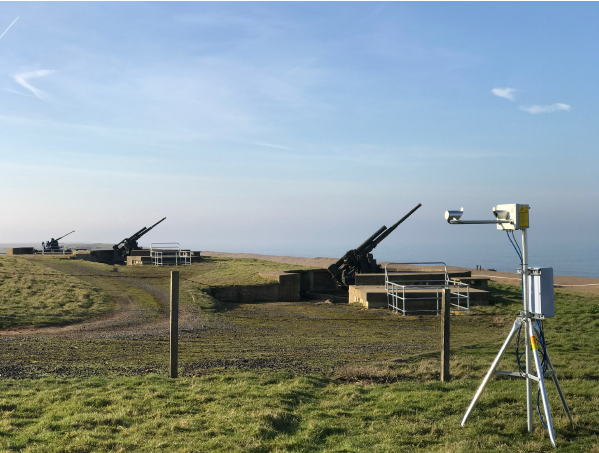
Figure 1. A DiVeN Thies LPM located at Weybourne Observatory in Weybourne, East Anglia, UK, which is an Atmospheric Mea- surement Facility (AMF) site, part of the National Centre for At- mospheric Science